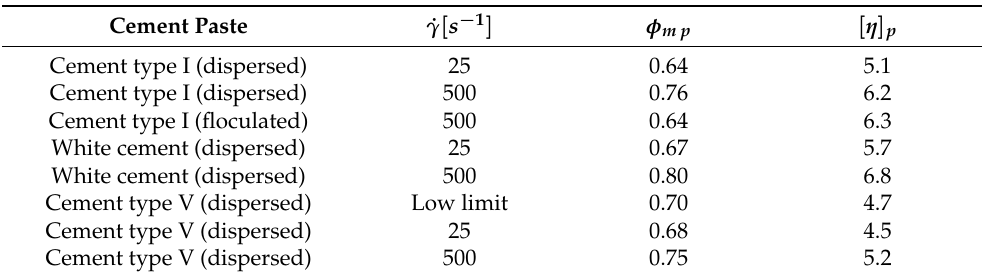
Table 2. Values of the parameters φ m p and [ η ] p in cement pastes calculated by Struble et al. [1]. Range of measure in rotational rheometer: 0–600 s − 1